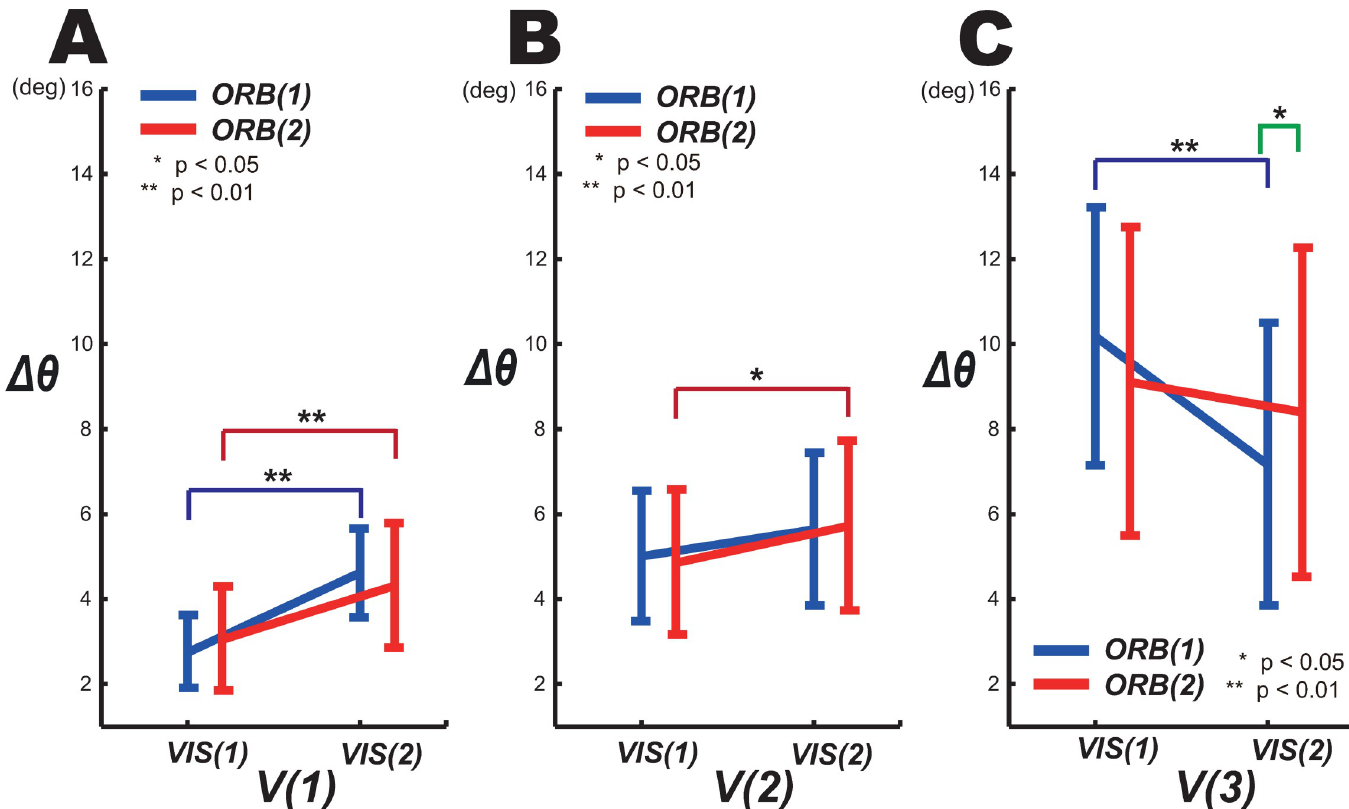
Fig 3. Effect of visuomotor control on Δ θ . For each ORB level, effects of VIS on Δ θ are shown at (A) 0.25, (B) 0.5, and (C) 0.75 Hz.